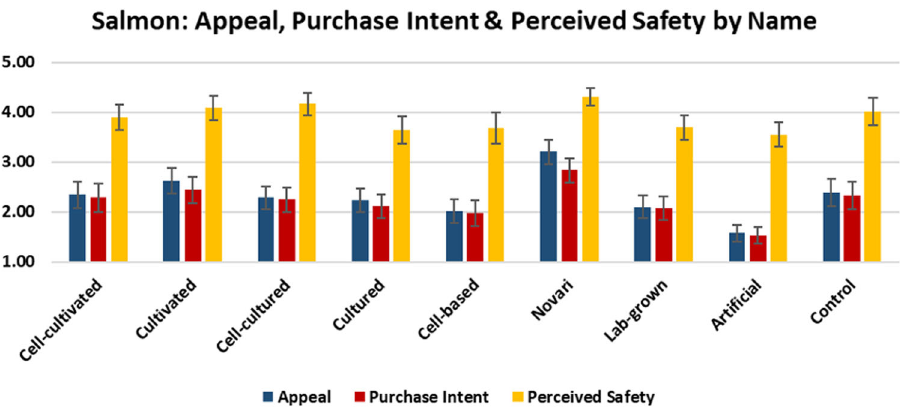
Table 7. Note that, for categorical variables, the reference values are Gender = Male and Region =